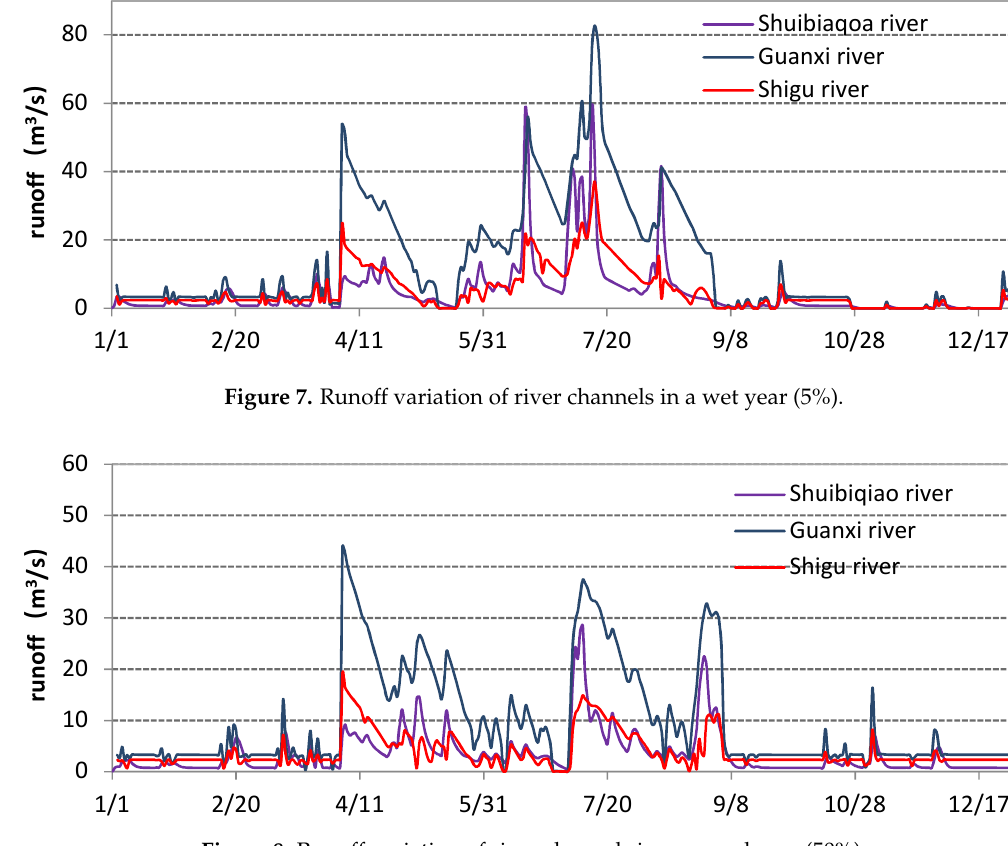
Figure 8. Runoff variation of river channels in a normal year (50%).